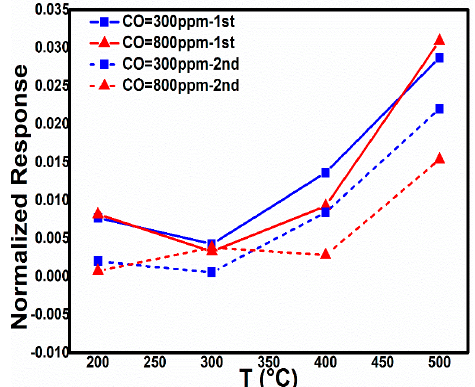
Figure 2. The increasing trend for the normalized response of Pt/Al 2 O 3 -gate SiC metal insulator semiconductor field effect transistor (MISFET) sensors with increasing operating